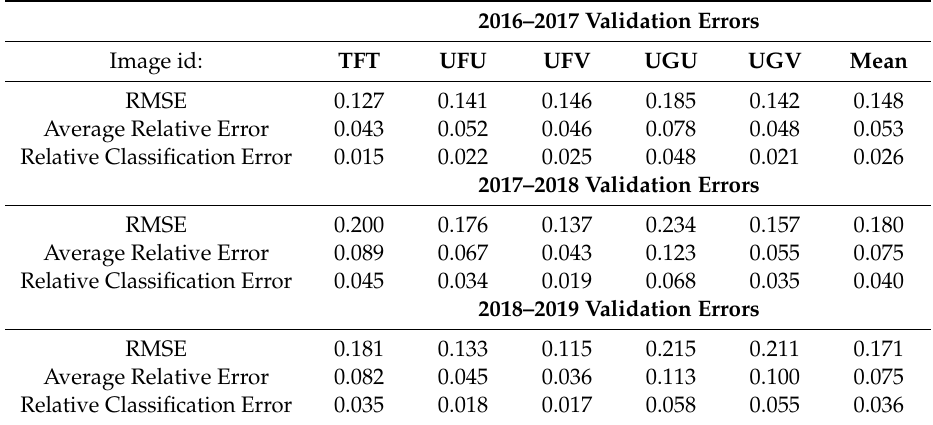
Table 2. Evaluation of Random Forests models predictive capabilities as estimated with the “out-of-bag” (i.e., validation) dataset. RMSE: Root Mean Square